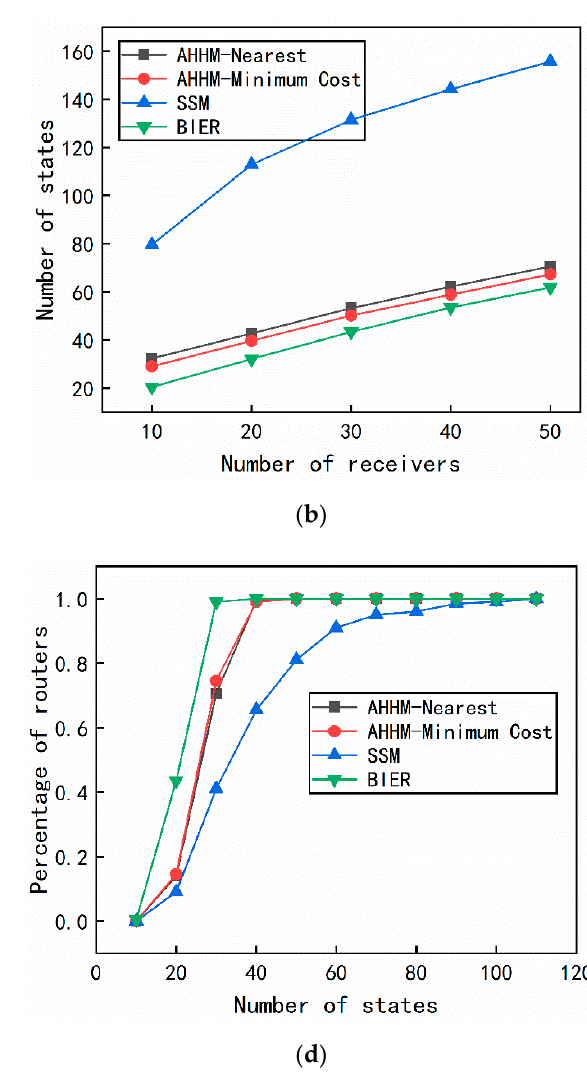
Figure 9. The comparison of multicast forwarding state. ( a ) The comparison of the number of multicast forwarding states with different thresholds; ( b ) The comparison of the number of multicast forwarding states with different numbers of receivers; ( c ) The comparison of the number of multicast forwarding states with different numbers of groups; ( d ) The CDF of the number of multicast forwarding states in each multicast method.